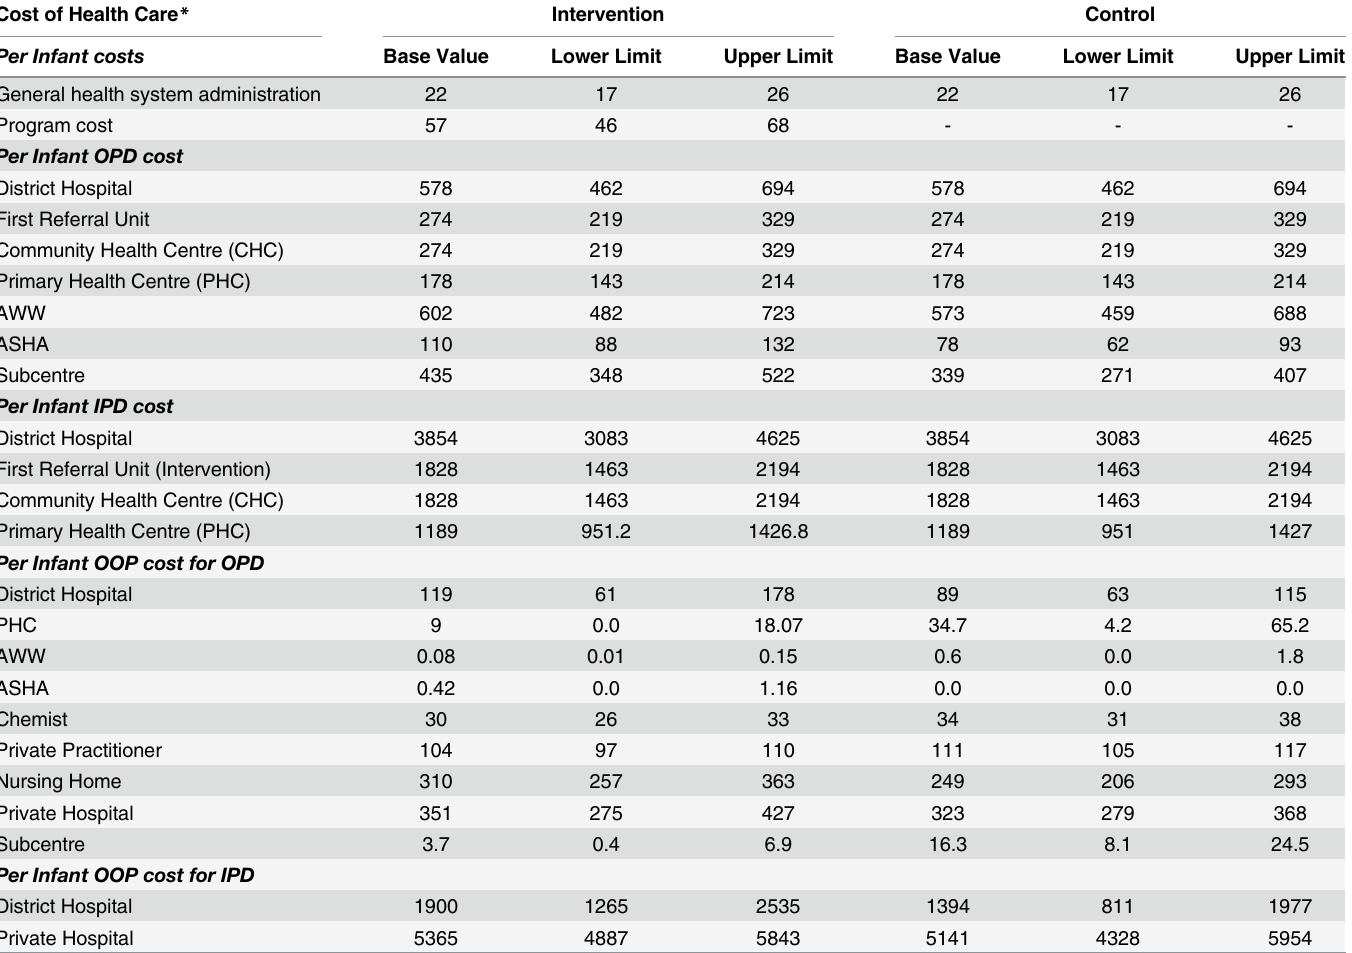
Table 3. Health system and out-of-pocket (OOP) Cost Parameters for IMNCI Cost Effectiveness Decision